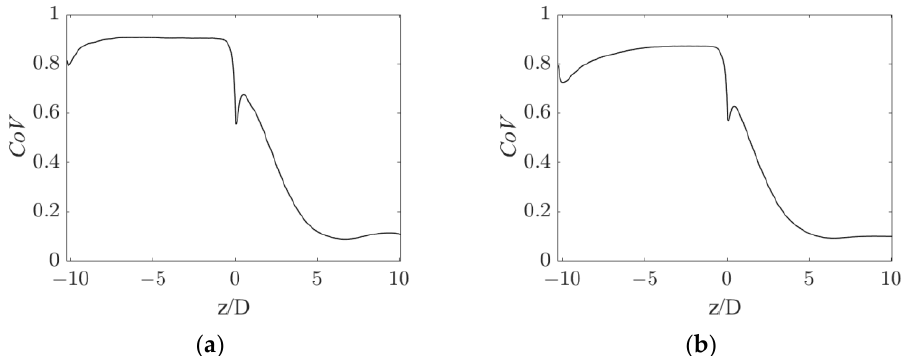
Figure 5. Axial profiles of gas volume fraction CoV for the operative conditions considered: ( a ) Q L = 3 /h and Q 25 m 3 /h and Q G = 3.75 L/min; ( b ) Q L = 30 m 3 /h and Q G = 7.5 L/min. ( a ) Q L = 25 m G = 3.75 L/min; ( b ) Q L = 30 m